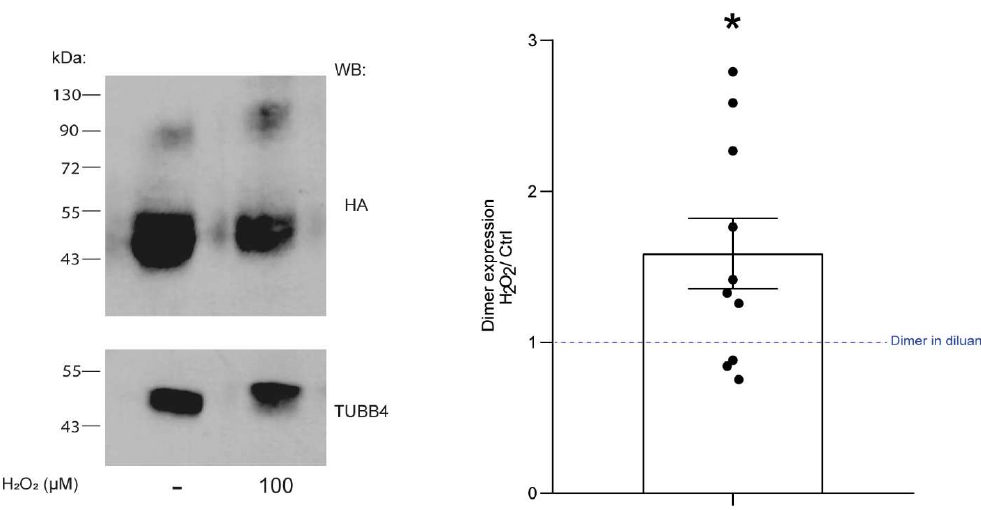
Figure 7. Oxidation enhances CLEC12A WT oligomerisation. HEK-293T cells transiently expressing CLEC12A WT were either incubated with 100 µM H 2 O 2 or diluent (H 2 O) prior to Western blot analysis with an anti-HA and TUBB4 antibody (loading control) . Densitometric analysis of the Western blot data was performed by calculating the ratio of CLEC12A dimer signal after H 2 O 2 incubation/CLEC12A dimer signal formed during incubation with the diluent. These data are representative of 10 independent experiments. Statistical analysis: One sample Wilcoxon test * p < 0.05.